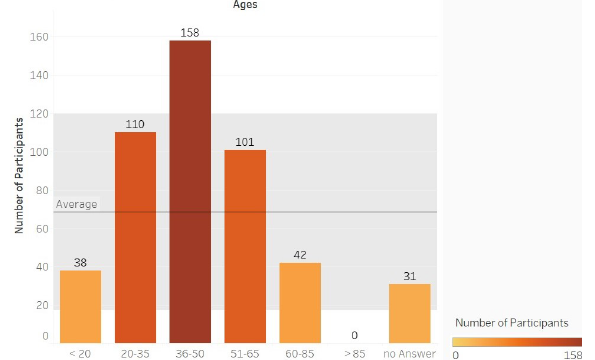
Figure 5. Age distribution